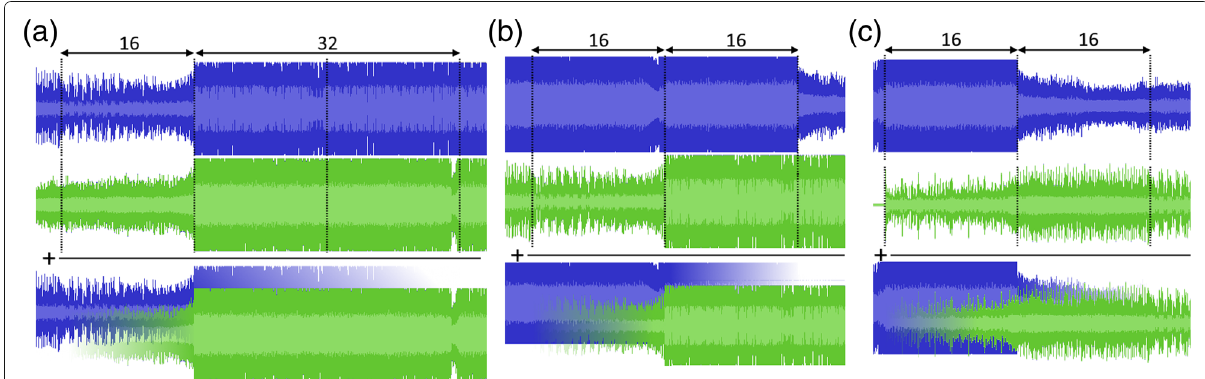
Fig. 11 Illustration of the cue point selection for the three transition types. The fade-in and fade-out lengths, expressed in number of measures, are annotated. Also the final crossfades are conceptually illustrated. a Double drop. b Rolling transition. c Relaxed transition